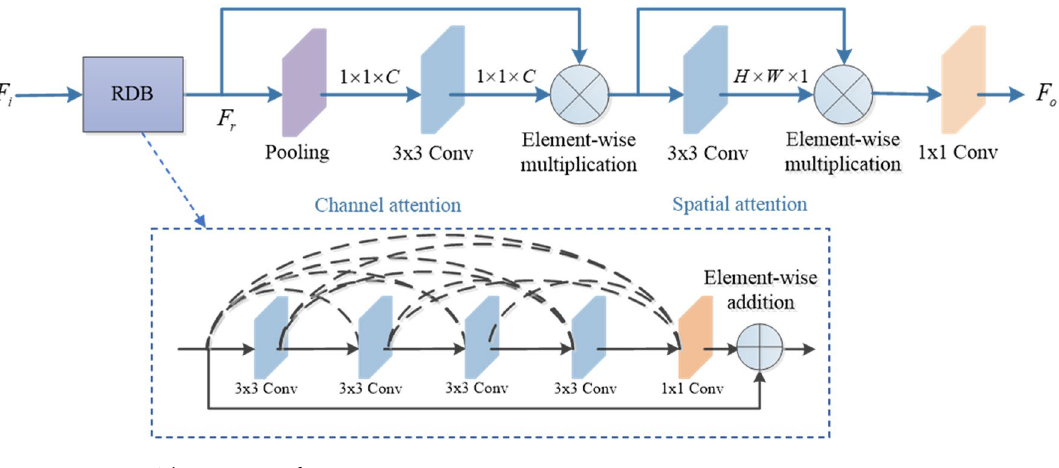
Figure 3. The structure of